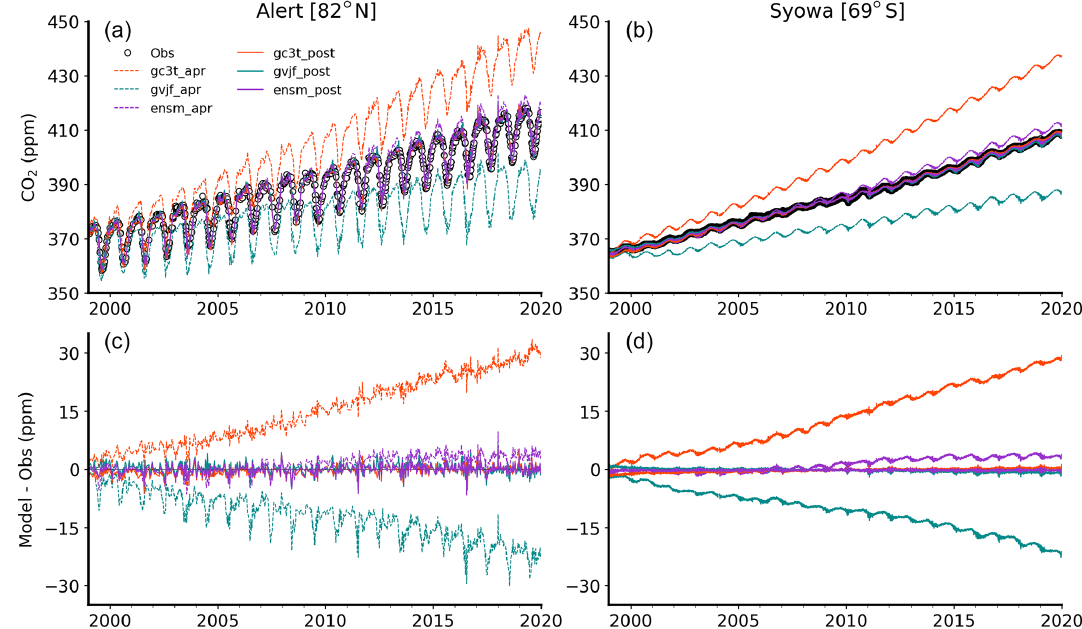
Figure 2. Time series of observed and model CO 2 time series for two a priori (apr) simulation cases (gc3t and gvjf) and posterior (post) flux simulation cases using control MDU and PFU case ux4 (a, b) . Results for the mean of two a priori flux cases and ensemble mean inversion case are also shown. The model–observation differences are shown in (c) and (d) . Results are shown for two sites, Alert (82 ◦ N, 63 ◦ W; measurements by Environment Canada) and Syowa (69 ◦ S, 40 ◦ E; measurements by Tohoku University/National Institute of Polar